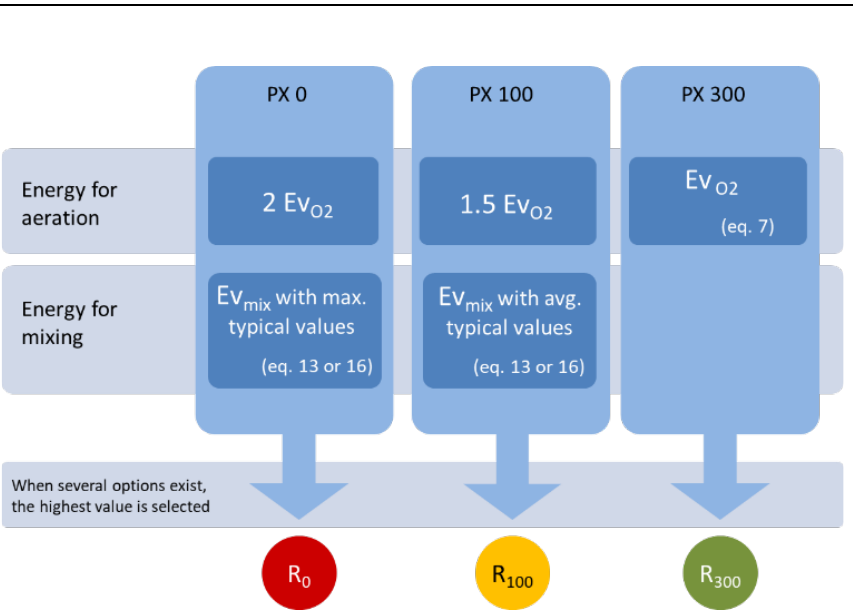
Figure 3. The stepwise procedure to obtain the reference values (R 0 to R 300 ) of the performance function of energy consumption for aeration and mixing in AS systems. Table 2. The reference values for the dissolved oxygen concentration in the AS reactor.